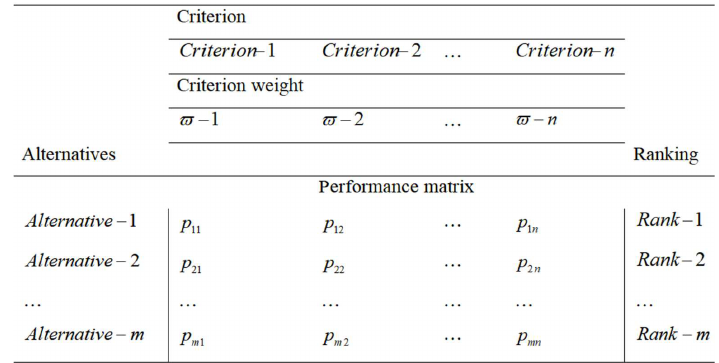
Figure 3. A MCDM model.